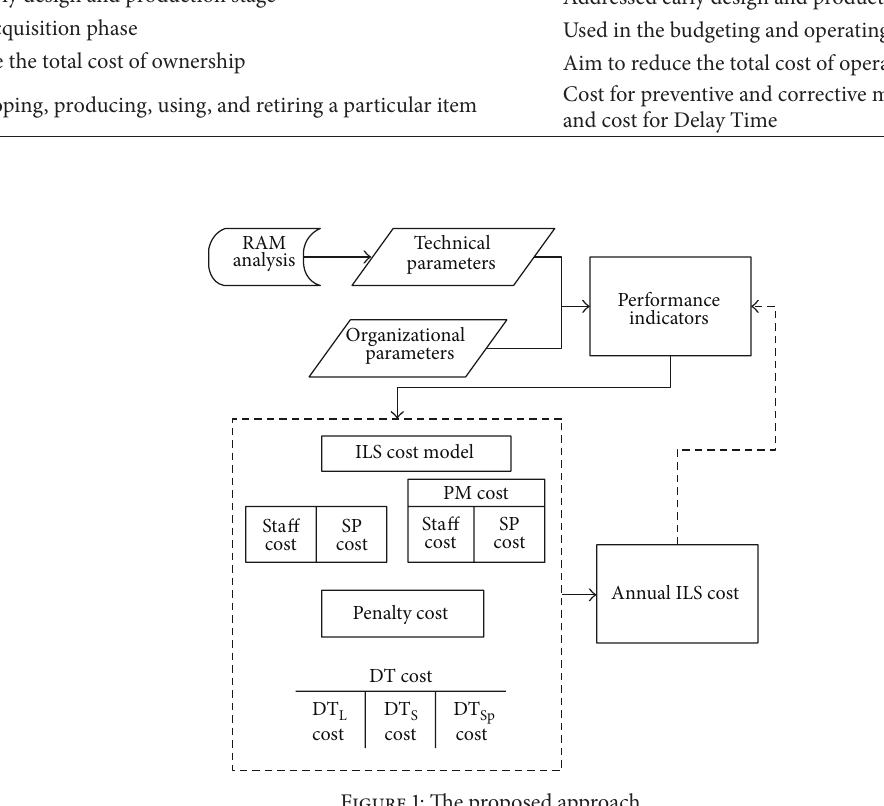
Figure 1: The proposed